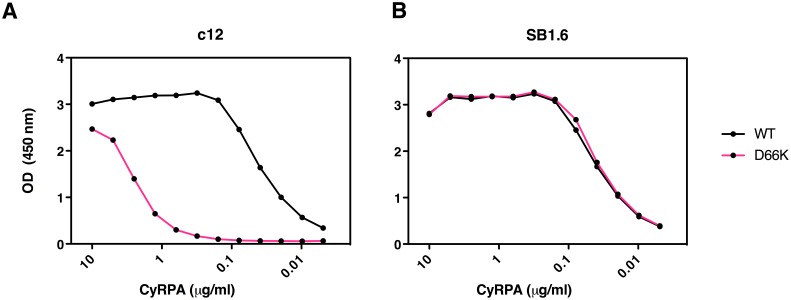
Identification of Asp66 as a key contact residue for PfCyRPA/c12 interaction.mAb binding to purified wild-type PfCyRPA and an Asp66Lys single amino acid sequence variant was analyzed by capture-ELISA experiments. ELISA plates were coated with 10 µg/mL anti-PfCyRPA mAbs and then incubated with serial dilutions of wild-type PfCyRPA (WT) or an Asp66Lys variant (D66K); HRPO-labeled anti-Histidine tag mAbs were used as detection antibody. (A) When compared to wild-type PfCyRPA, the Asp66Lys single amino acid exchange strongly reduced the binding to mAb c12 mAb (epitope group B; Figure 1). (B) In contrast, the Asp66Lys amino acid exchange did not affect the binding of the mAb SB1.6, which belongs to epitope group F.